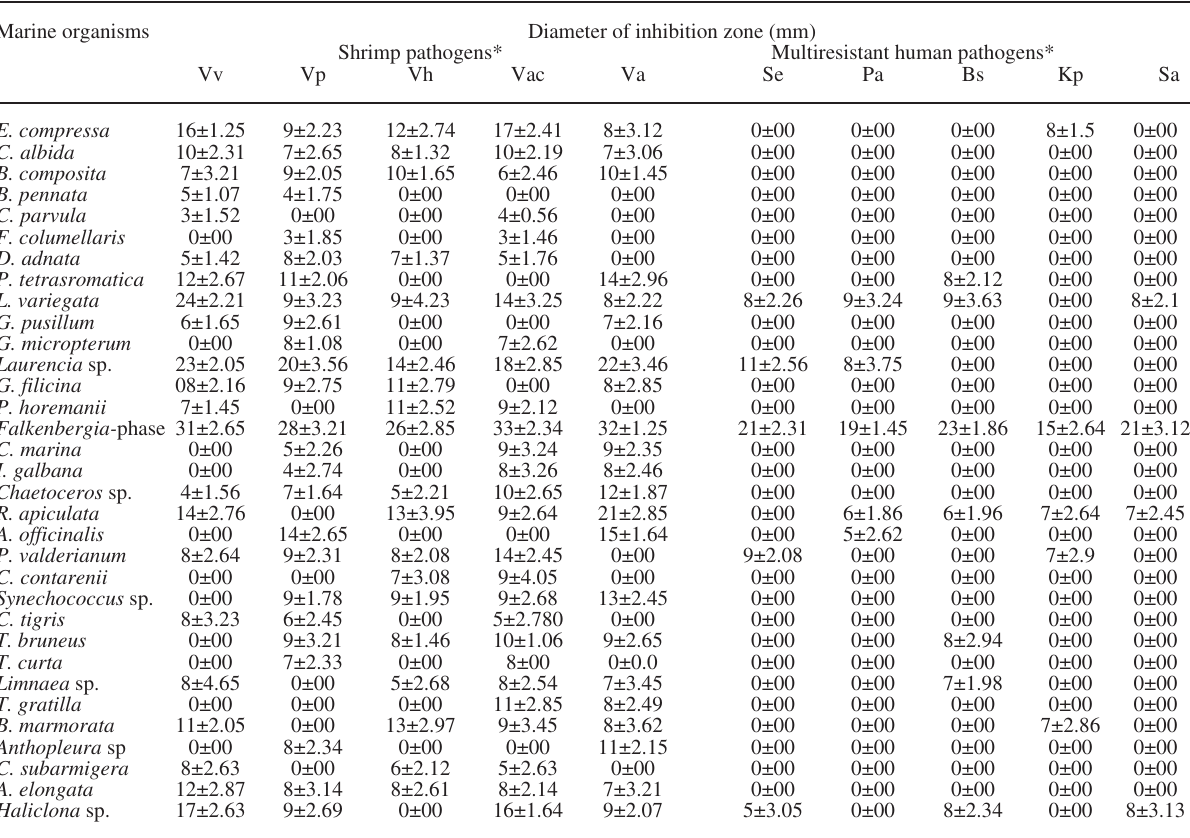
Fig . 1. – Map showing the studied area of the Kollam coast (south- west coast of Table 2. – Antimicrobial activity of flora and fauna collected from the Kollam coast.